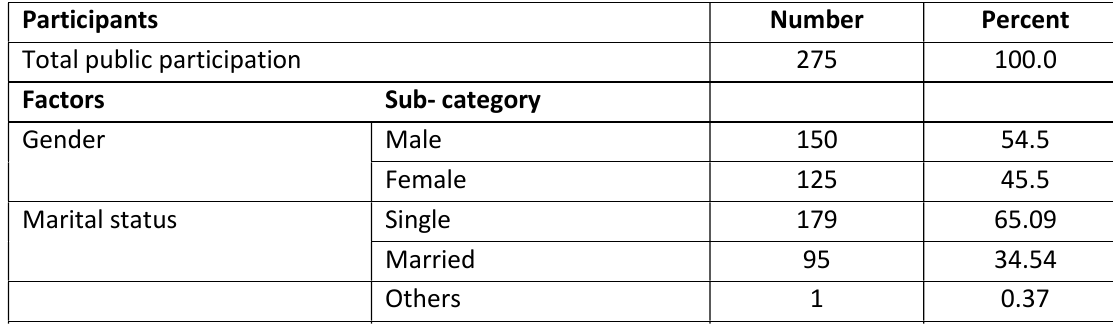
Table 1: Participants‘ Demographic Information and Park Use Patterns